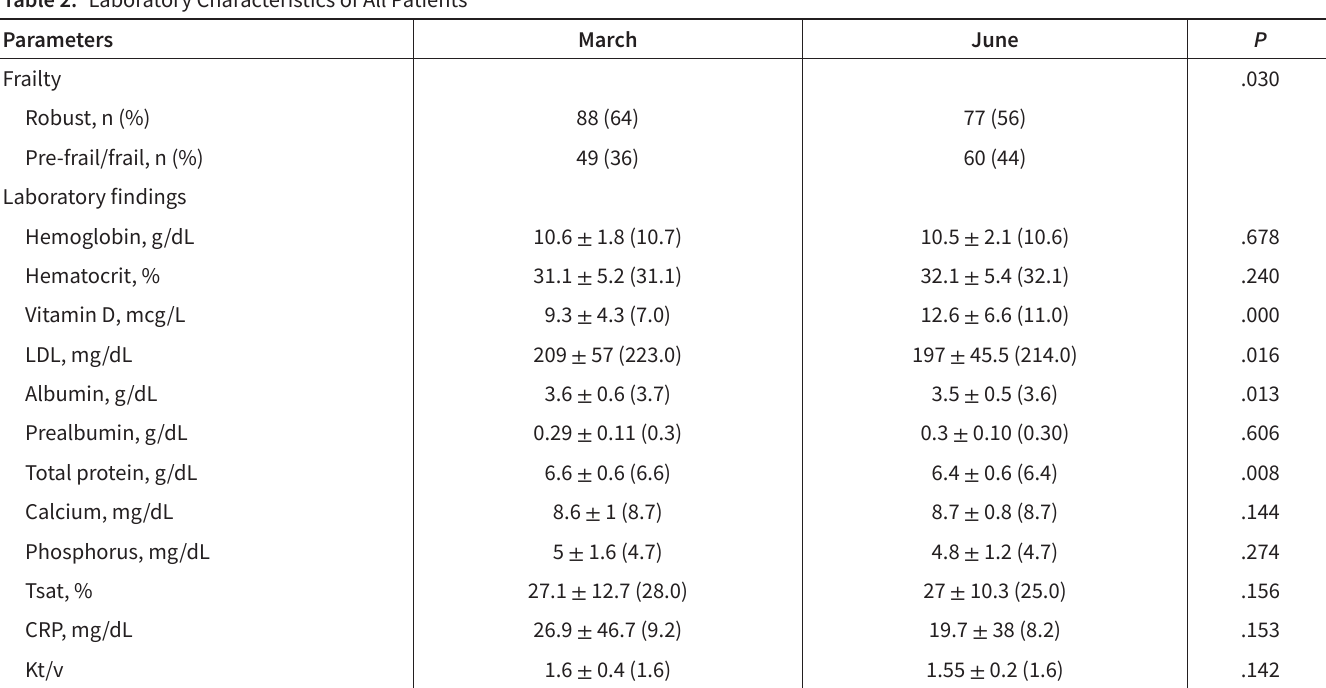
Table 2. Laboratory Characteristics of All Patients Parameters